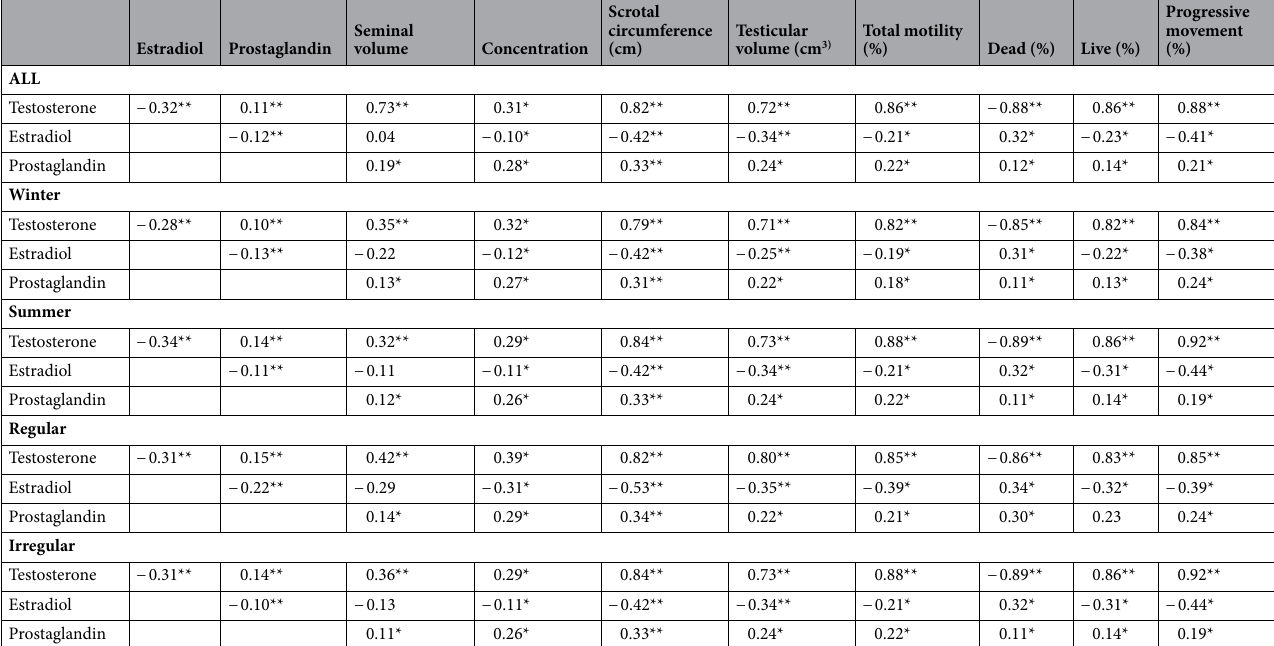
Table 11. Correlations of hormone levels and semen quality, taking into account the semen collection season. Explanation: ** P ≤ 0.01; * P ≤ 0.05; ns = P > 0.05.